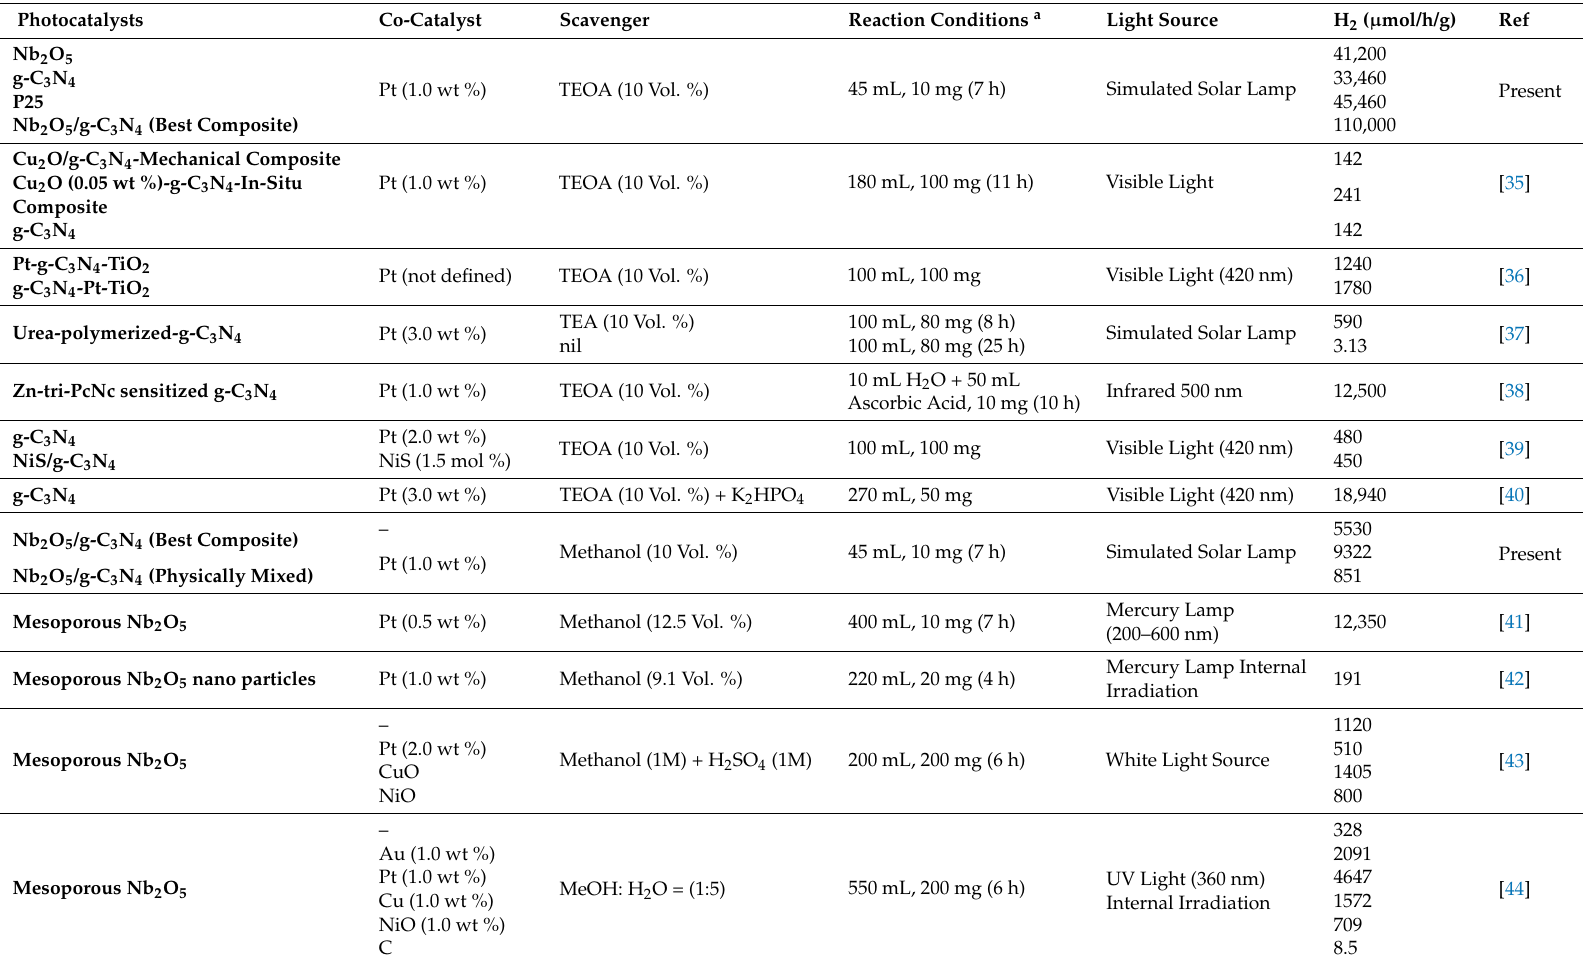
Table 1. A brief comparison of present molecular H 2 evolution rate employing g-C 3 N 4 and/or Nb 2 O 5